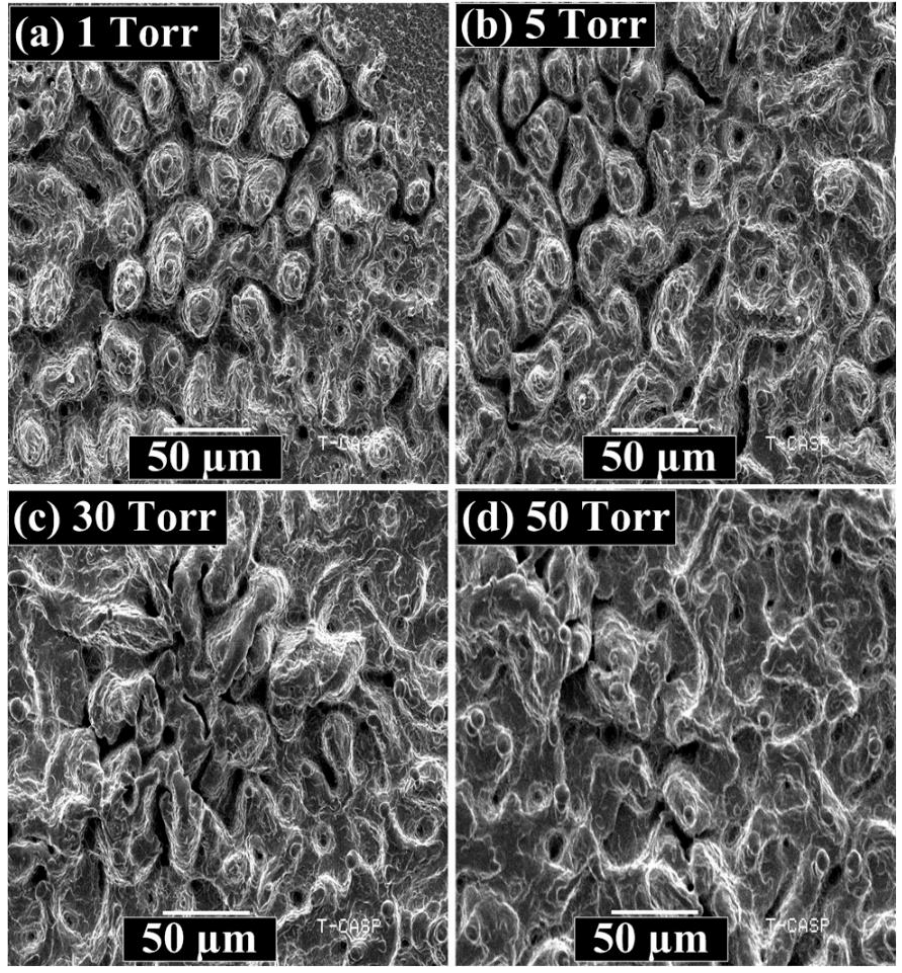
Figure 13. Surface morphological modifications in a Ne ambient environment at different pressures, ( a ) 1 torr, ( b ) 5 torr, ( c ) 30 torr, and ( d ) 50 torr, with a laser irradiation of 3.8 GW/cm 2 in the TMF. The non-uniform cavities between the cones are observed. For a pressure of 5 torr, the uniformity of spherical-top-head cones is decreased. The laser-induced molten material and groove-like cavities are seen. In Figure 13c, the irregular flower structure can be seen. The non-uniform cones are observed, and, at the outer edges of the flower, the molten material is seen. In Figure 13d, the flower structure has vanished and transformed into irregular cones with an extended top head on the droplets. The irregular cavities are also prominent at the highest pressure, 50 torr. SEM images of Figure 14a–d reveal the laser-irradiated area of Cu-metal without a magnetic field under He environment at different pressures of 1, 5, 30, and 50 torr. The spherical cones, uplifted droplets, and cavities are dominant features at all pressures. For the lowest pressure of 1 torr, irregular cones with cavities and turbulent melt flow between the cones are seen in Figure 14a. In Figure 14b, a flower-like structure is seen. The spherical-top-headed cones of wider bases are the boundary of the flower